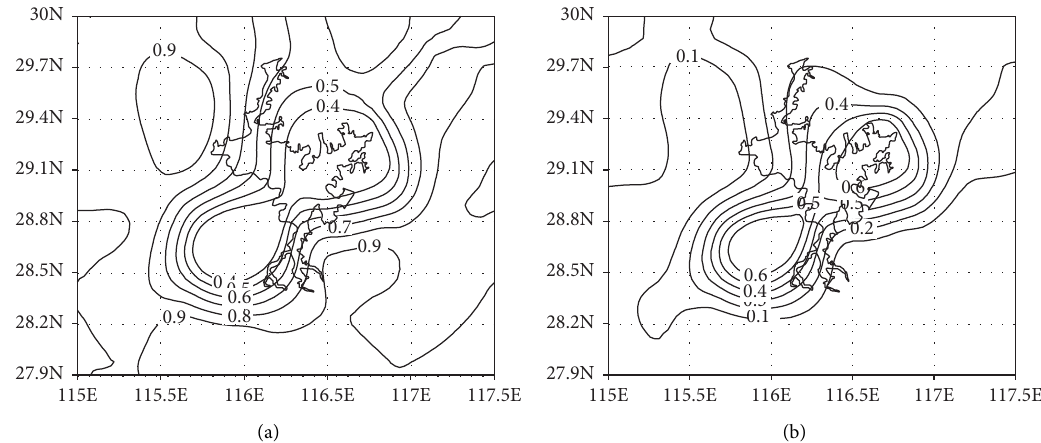
Figure 4: The variance contributions of (a) diurnal (24hours) cycle and (b) semidiurnal (12hours) cycle.